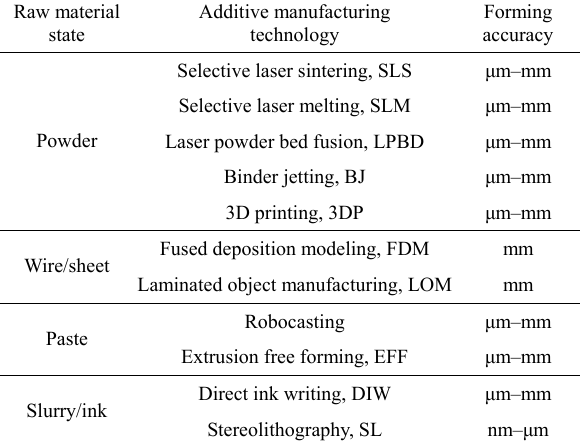
Comparison of various direct additive manufacturing technologies of SiC ceramic Raw material state